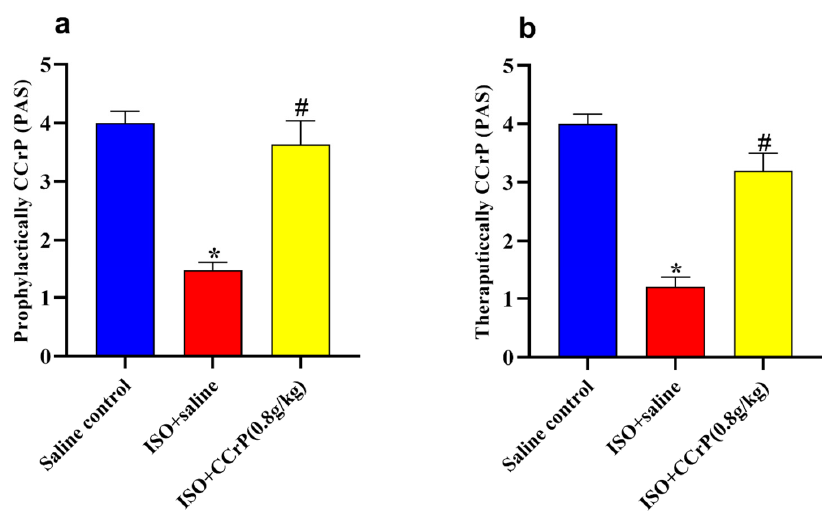
Figure 8. Treatment of CCrP at the dose of 0.8 g/kg/day restores normal physical activity in both prophylactic ( a ) and therapeutic ( b ) regimens. Data are presented as mean ± S.E.M. of 4–6 rats. *: statistical significance ( p < 0.05) compared to the control/saline group, #: statistical significance ( p < 0.05) compared to the ISO + saline group. ISO: isoproterenol; CCrP: cyclocreatine phosphate; PAS: physical activity score.